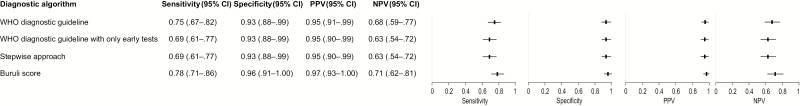
Accuracy estimates of various diagnostic approaches. Abbreviations: CI, confidence interval; NPV, negative predictive value; PPV, positive predictive value; WHO, World Health Organization.